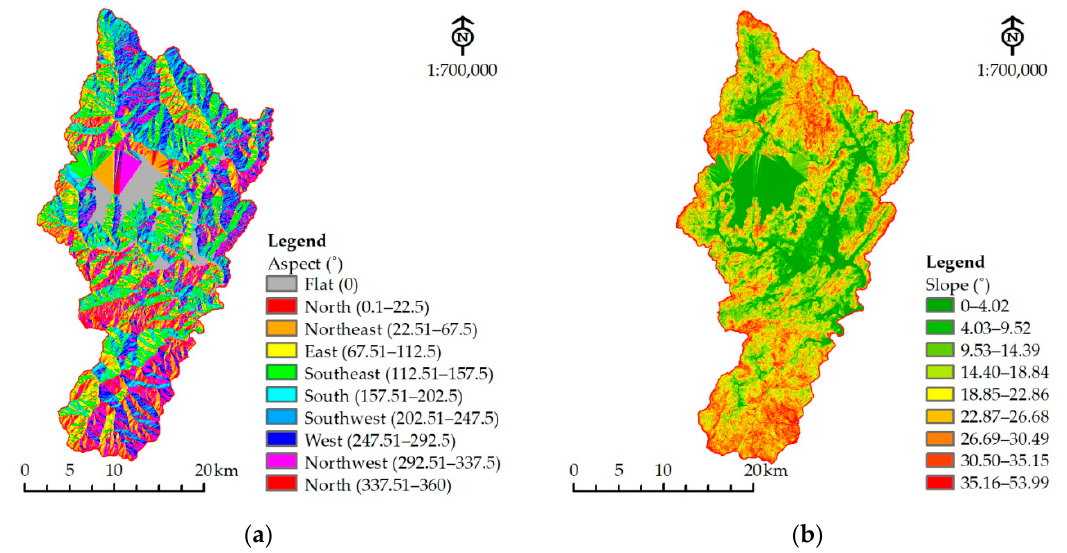
Figure 3. Thematic map for each growth factor of WSG using the digital topographic map; ( a ) thematic map for aspects within the study area; ( b ) thematic map for slope within the study area.